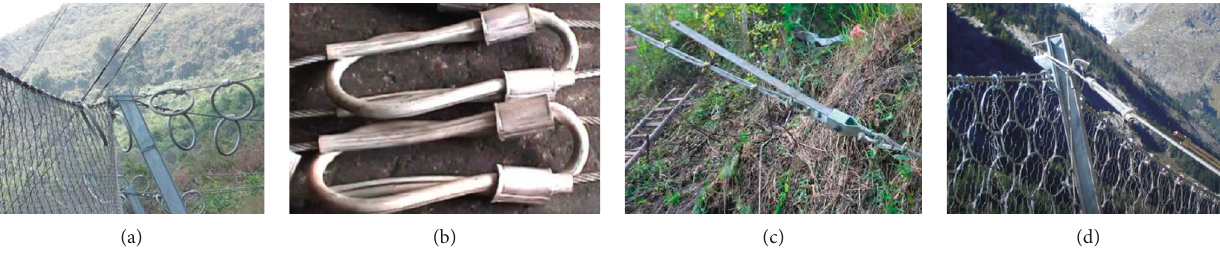
Figure 1: The most widely used dissipators in rockfall engineering. (a) Ring brake. (b) Double-U ring brake [6]. (c) U-shape dissipator. (d) Metal-tube-crushing